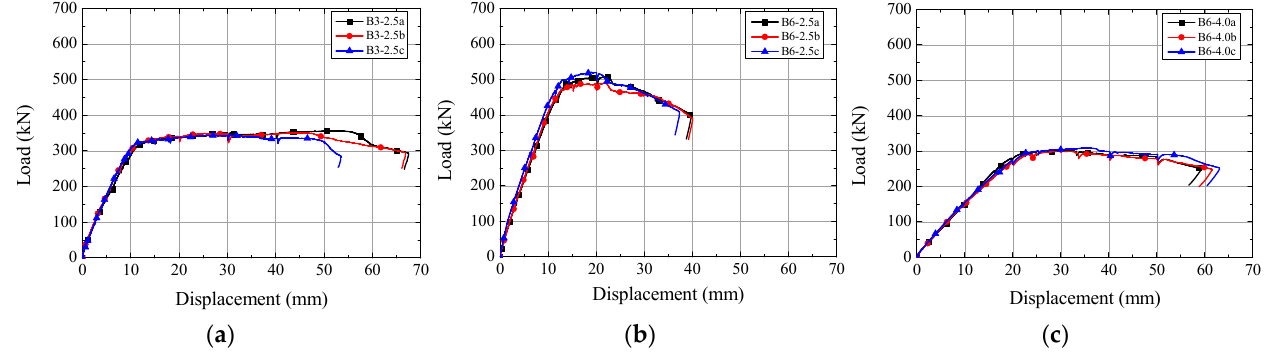
Figure 4. Load vs. displacement relationships of tested specimens: ( a ) B3-2.5 Series; ( b ) B6-2.5 Series; ( c ) B6-4.0 Series. Table 3. Load and deflection capacities of specimens obtained from this study.